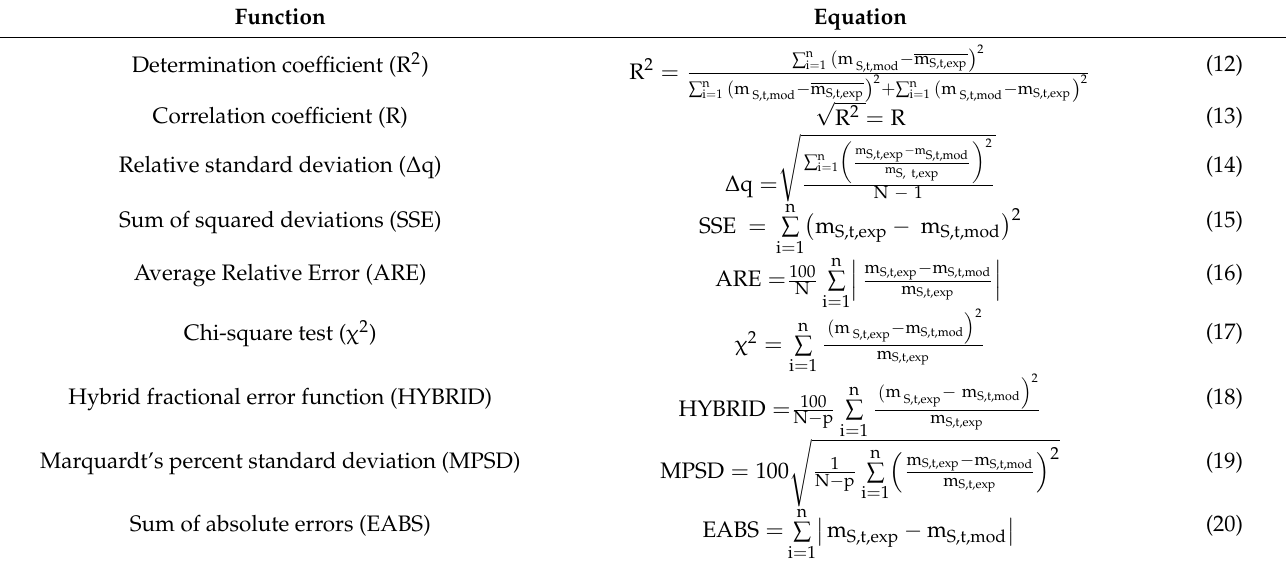
Table 1. Statistic error functions